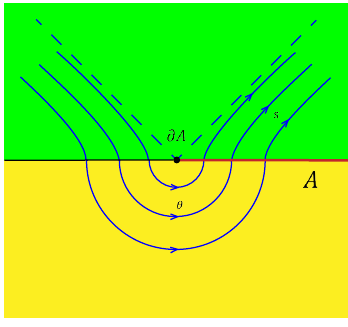
Figure 3 . Analytic continuation between local Lorentzian (top) and Euclidean (below) modular